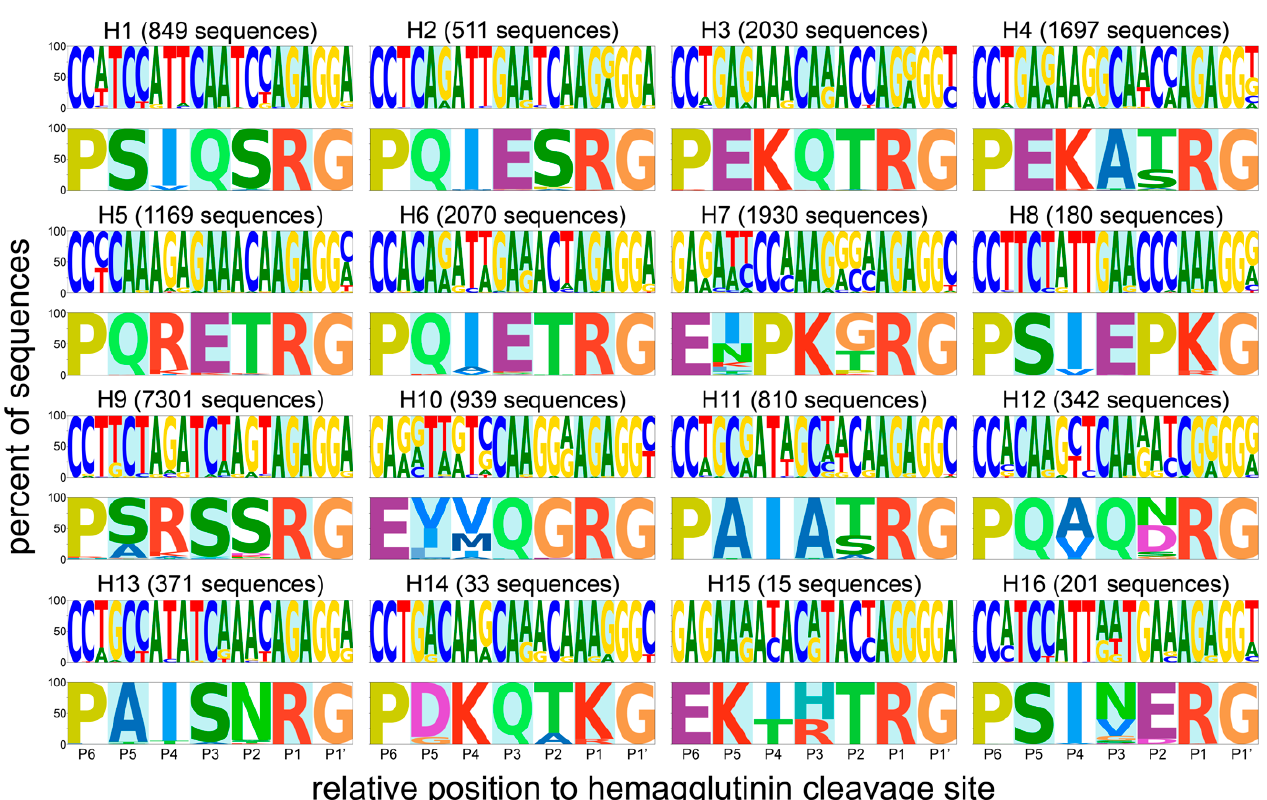
Figure 2. Sequence logos of nucleotide and amino acid composition of HA cleavage site regions (P6 to P1 ′ , P1 position corresponding to the C-terminus of HA1) of different subtypes. For each HA subtype, the number of sequences used to generate the logo is indicated. Letter sizes are directly proportional to the percentage of sequences presenting a given character, as indicated on the y-axes.